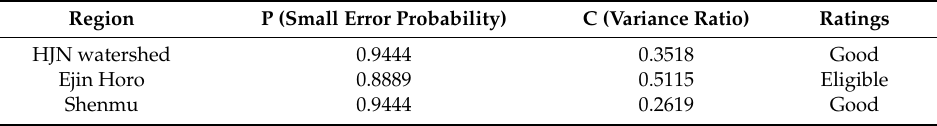
Table 2. Prediction accuracy and level and ratings of the grey